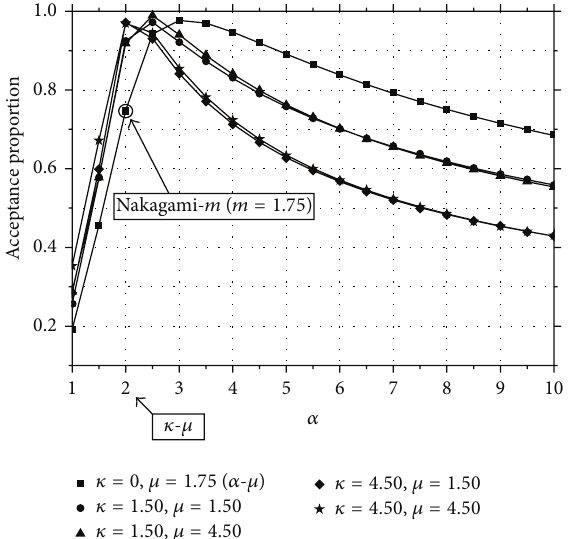
Figure 2: Rejection method efficiency for the 𝛼 - 𝜅 - 𝜇 distribution.